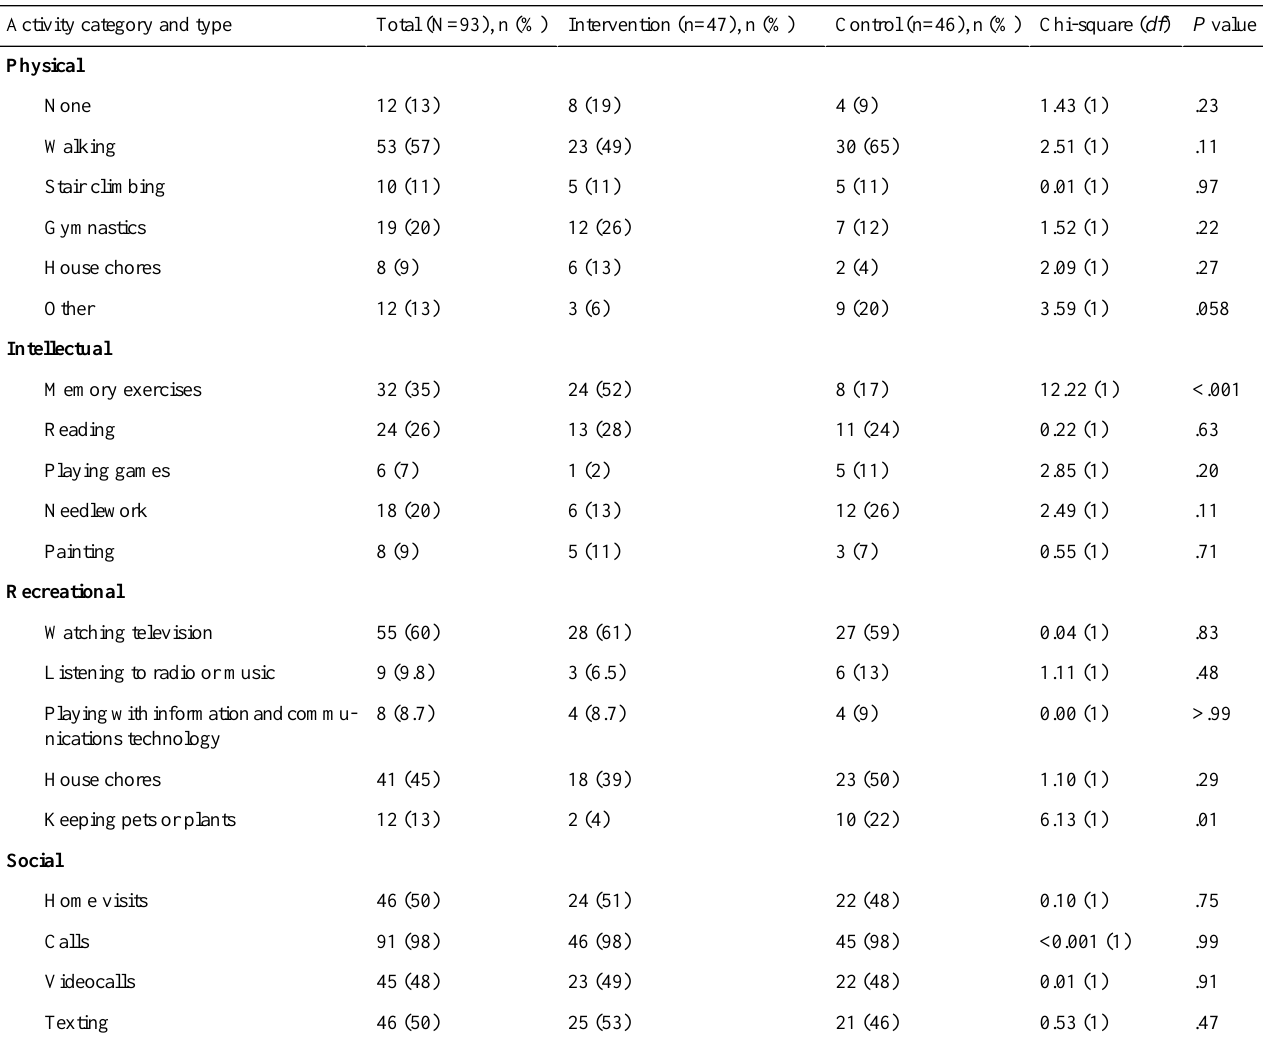
Table 3. Differences between the intervention and control groups regarding